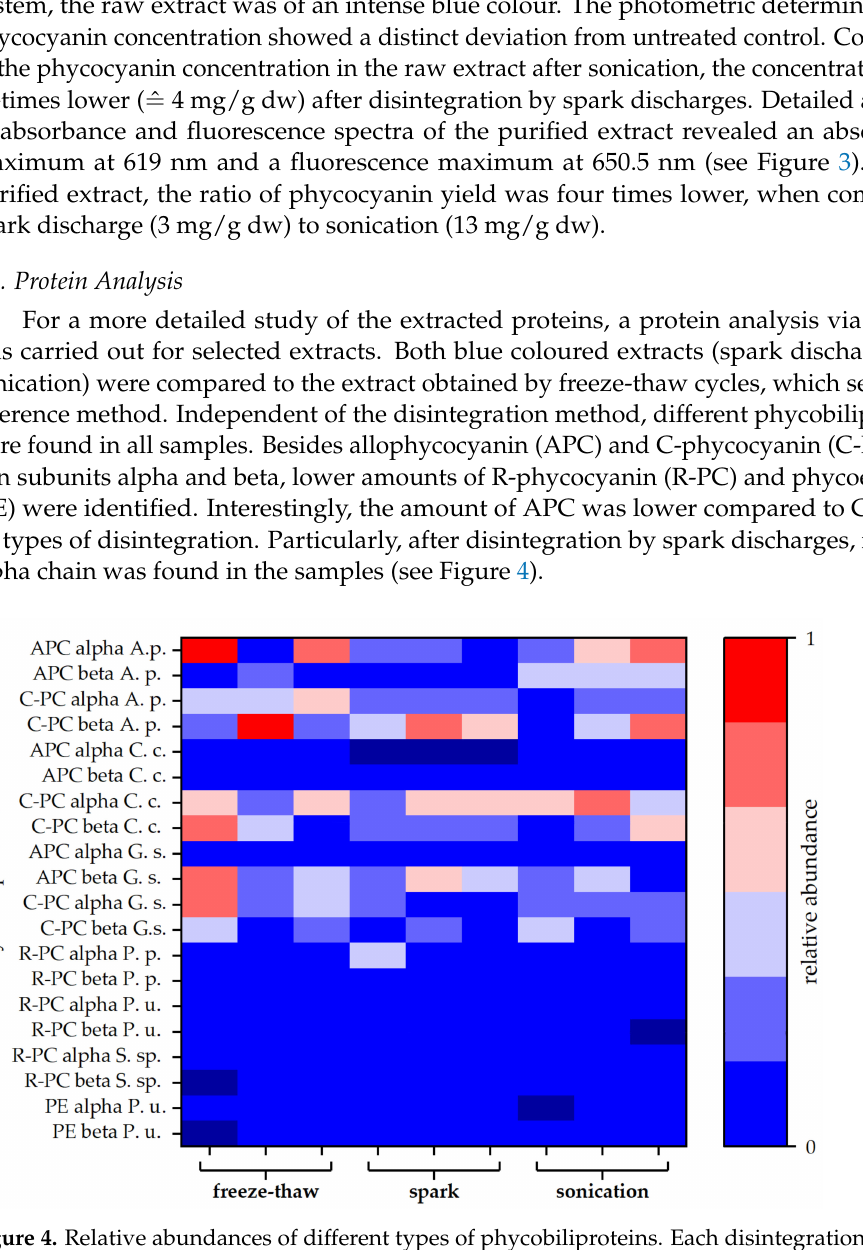
Figure 4. Relative abundances of different types of phycobiliproteins. Each disintegration method was performed in triplicate. Abundances are given as averages of duplicates obtained by MS-protein analysis. Allophycocyanin (APC), C-phycocyanin (C-PC), R-phycocyanin (R-PC), and phycoerythrin (PE) sequences of different species were obtained from the Uniprot ® database. Protein composition of the attained extracts was compared to phycobiliproteins of Arthrospira platensis (A. s.), Cyanid- ium caldarium (C. c.), Galdieria sulphuraria (G. s.), Porphyridium purpureum (P. p.), Polysiphonia urceolata (P. u.), and Synechococcus sp. (S.